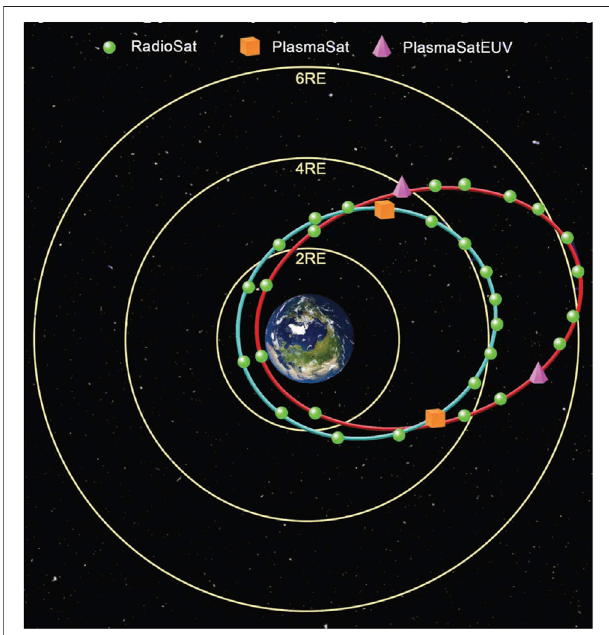
FIGURE 3 | PILOT spacecraft orbits, shown from a vantage point orthogonal to the orbit plane, which has a 0 o latitude inclination.